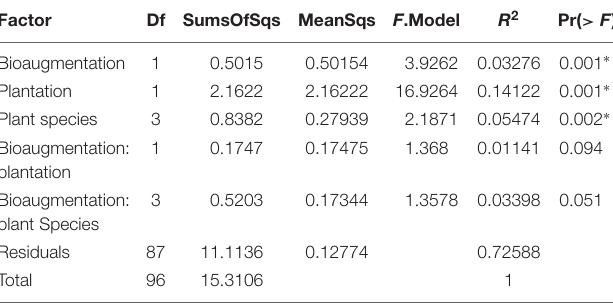
TABLE 1 | PERMANOVA analysis of the effects of the plantation, plant species identity and bioaugmentation on bacterial community structure in the substrate based on the Bray–Curtis dissimilarity indices.